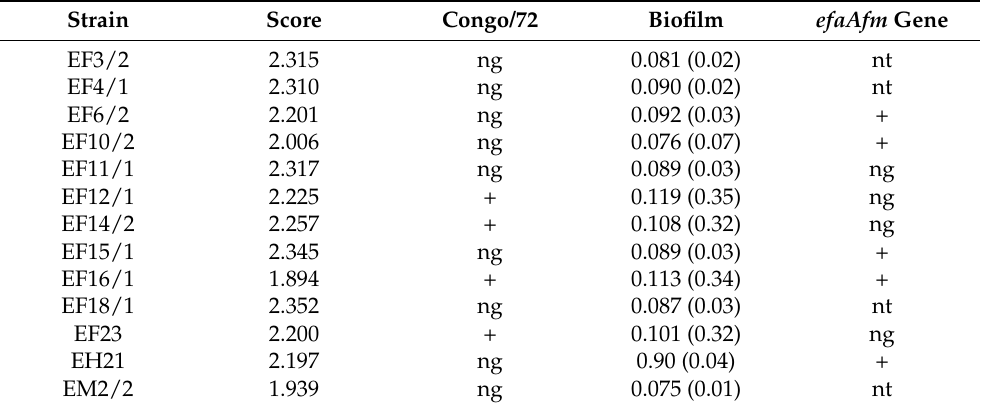
Table 1. Enterococci detected in raw goat milk, with biofilm formation and virulence factor gene